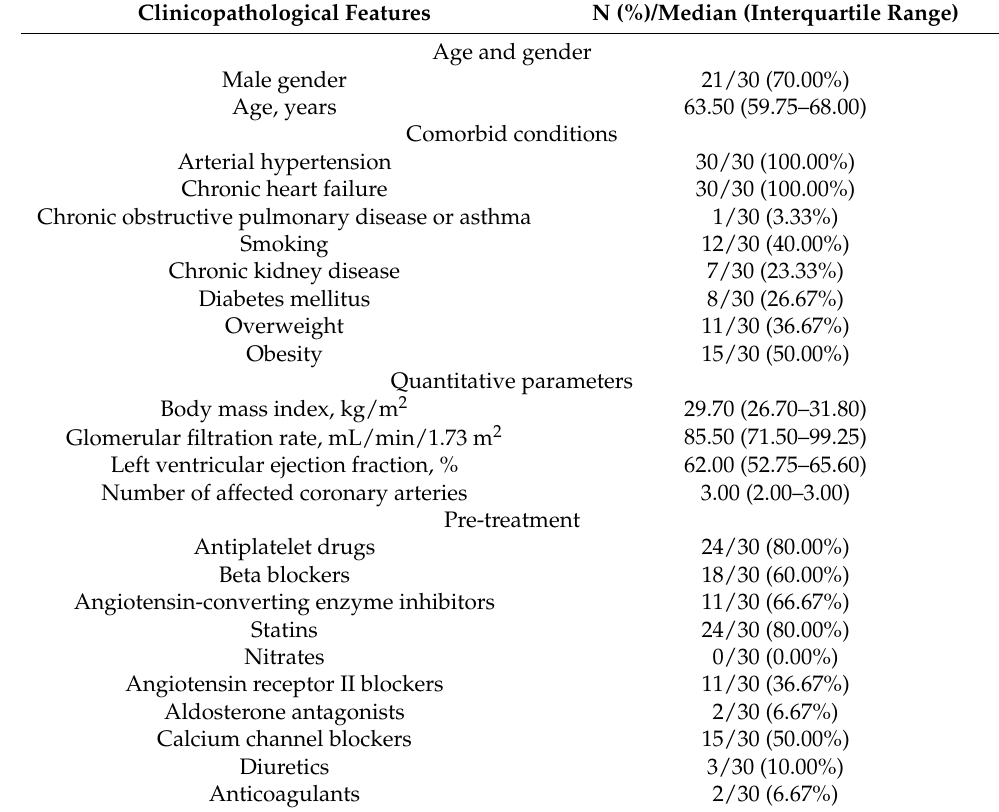
Table 1. Clinicopathological features of the patients who underwent CABG